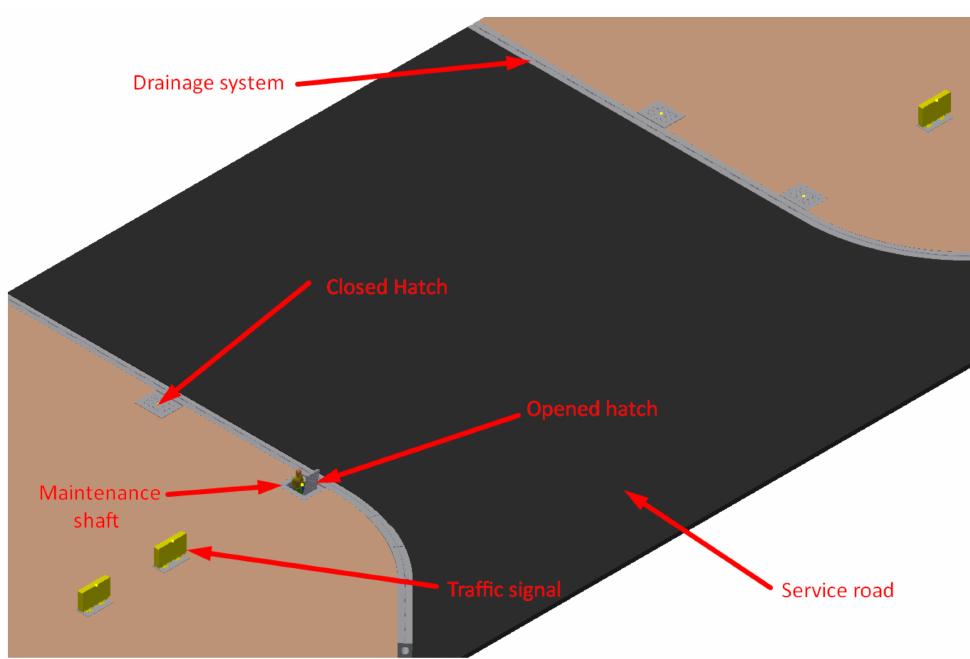
Figure 1. The 3D model of part of the service road located at the